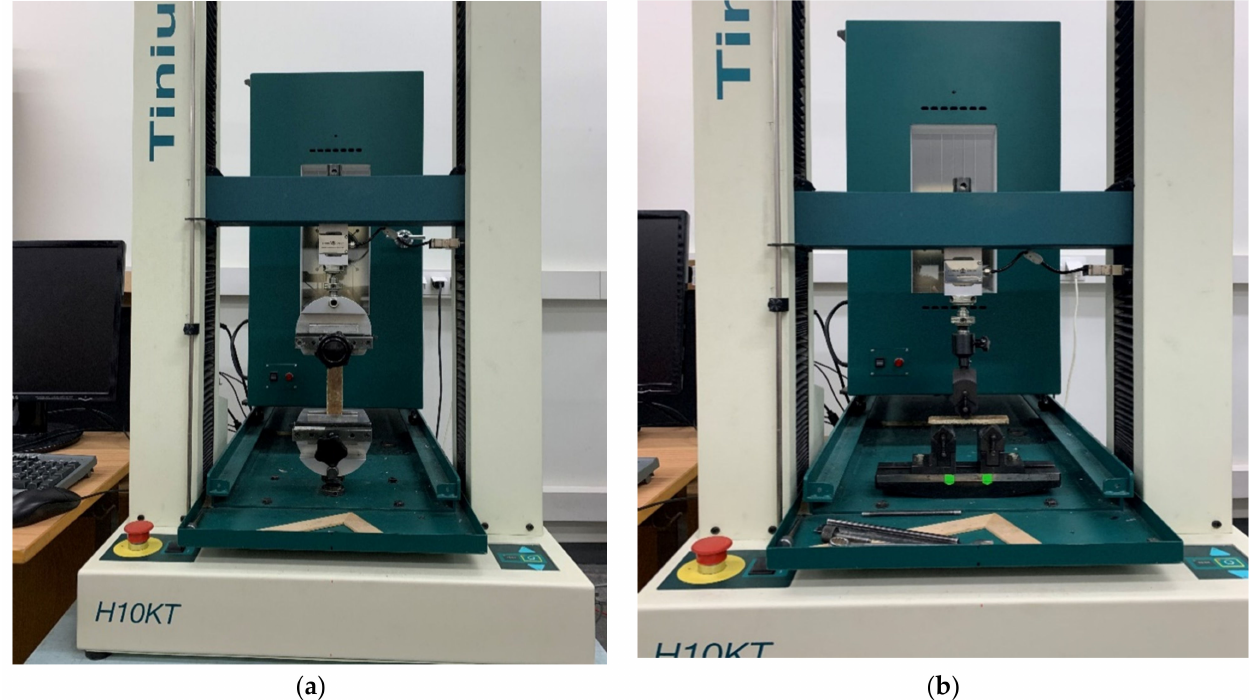
Figure 3. Tensile test ( a ) Flexural test (Three-point bending test) ( b ) on Tinus Olsen